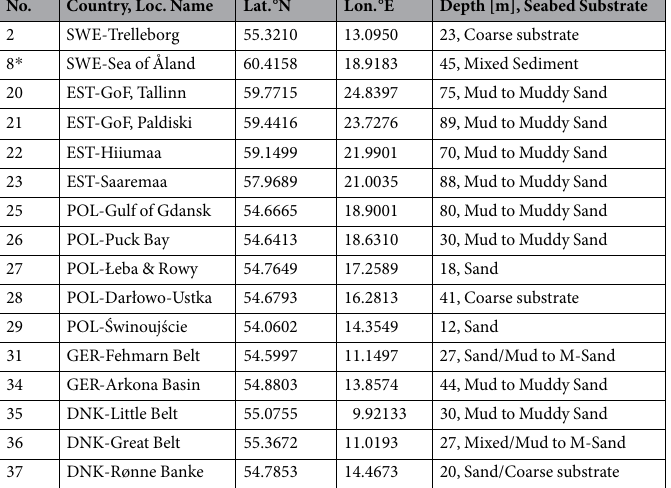
Table 1. Selected monitoring locations from the BIAS-project. Seabed substrate data originates from EMODnet (http://www.emodnet-geology.eu/). The asterisk behind location 8 is to point out significantly lower data coverage (May to December 2014, coverage 64% against 88–100% for the other